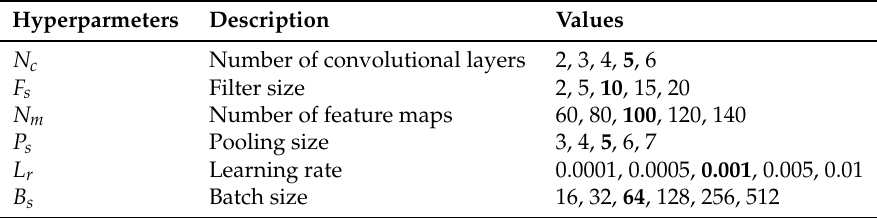
Table 4. List of hyperparmeters for the proposed CNN. The value in bold is the best setting of each hyperparameter.